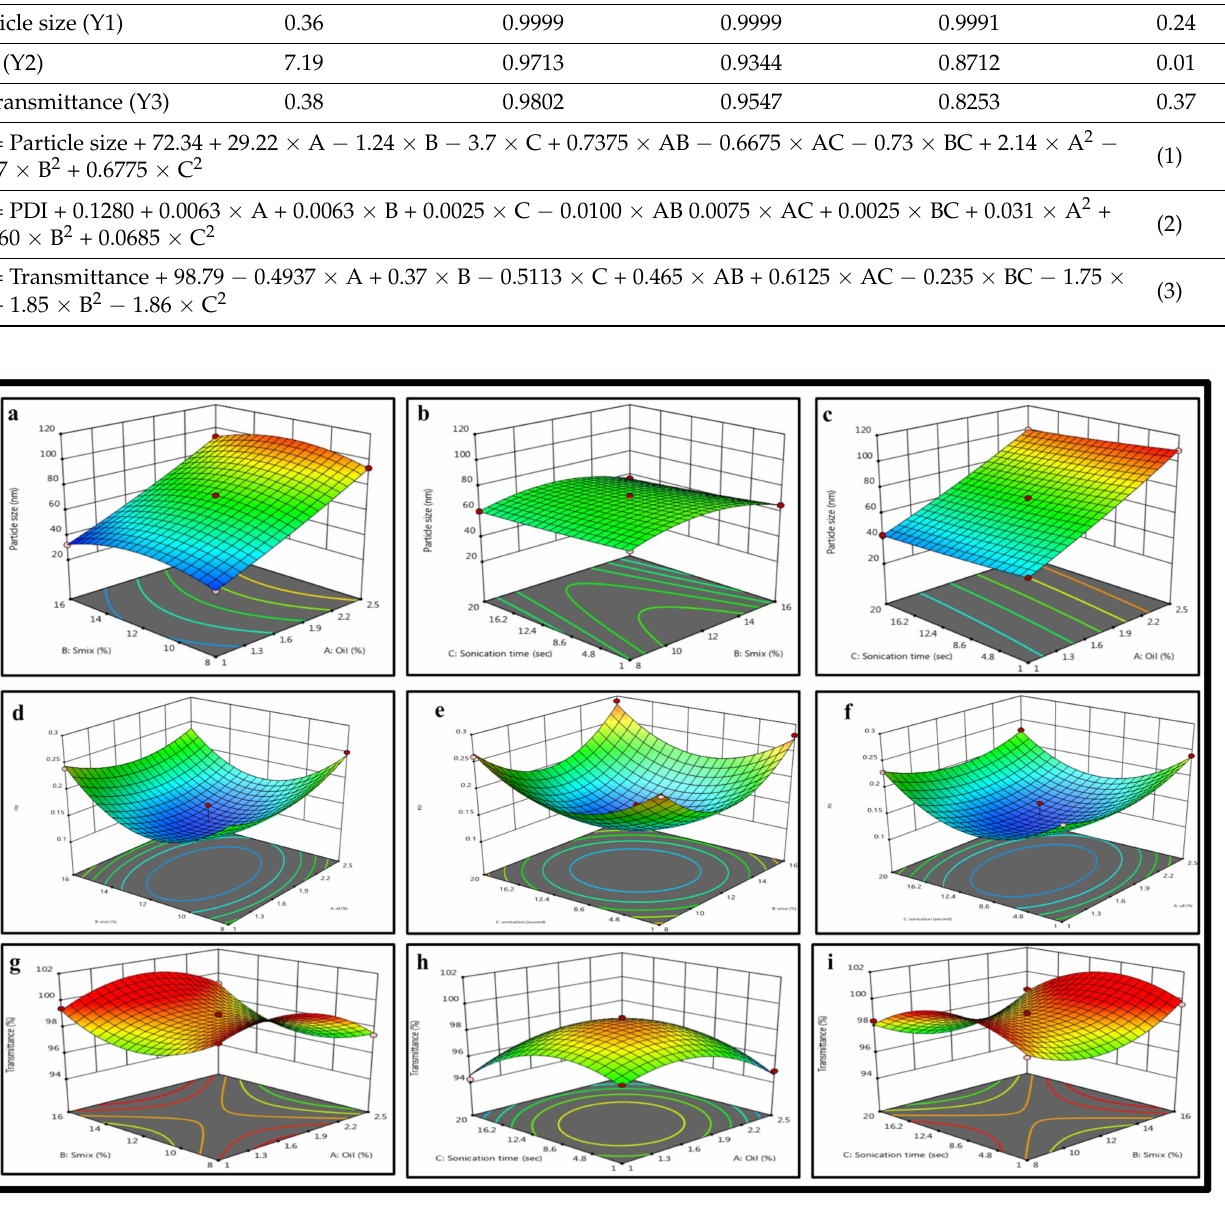
Figure 3. 3D response surface depicting the interaction effect of the independent variables like oil, smix, sonication time on ( a – c ) particle size, ( d – f ) PDI, and( g – i )